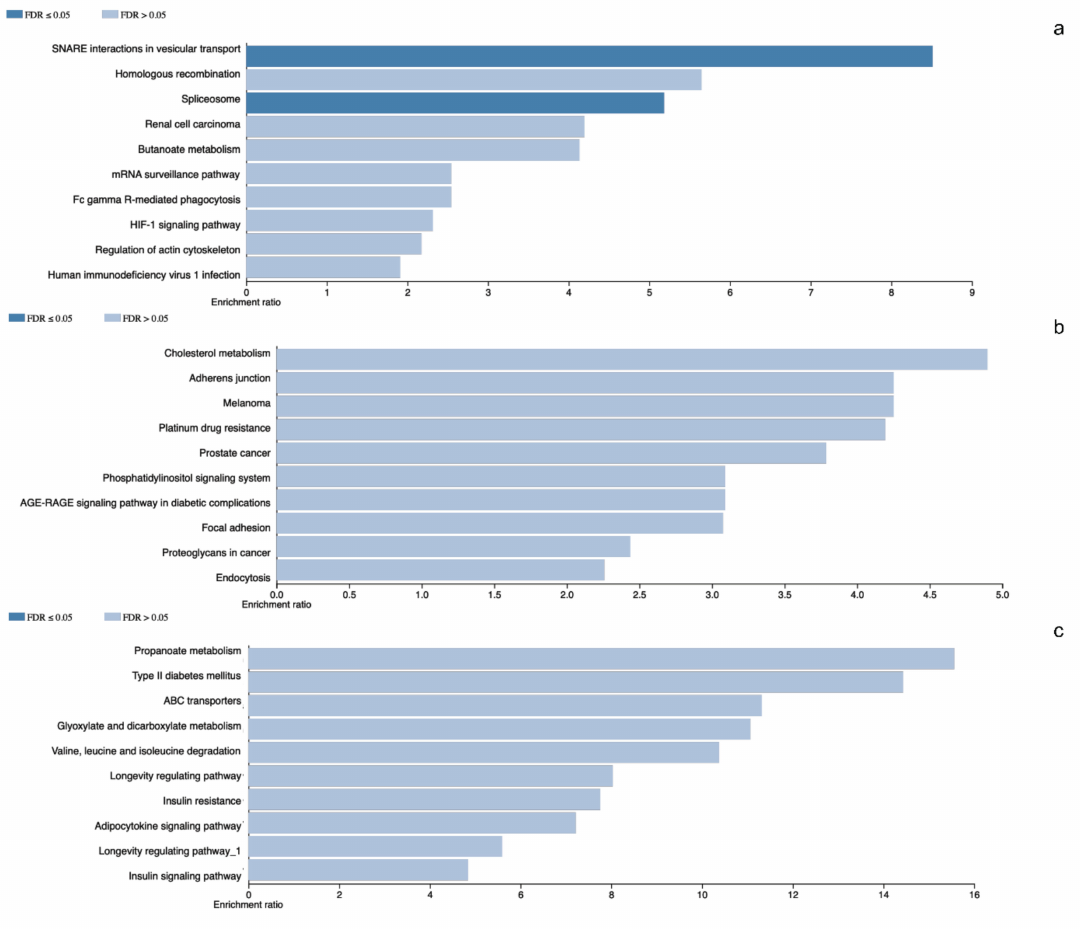
Figure 3. Panel ( a – c ) represents gene ontology results from the di ff erentially identified and characteristic proteins in NR5A1 - and POU1F1 -derived pituitary tumors and control gland,